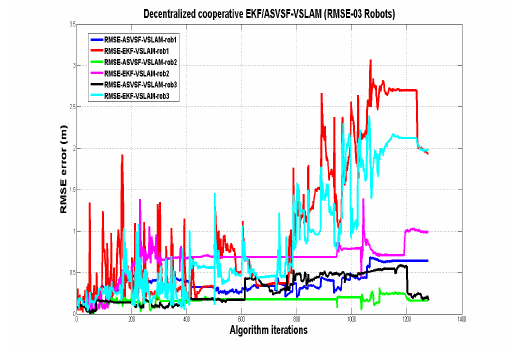
Fig. 11: RMSE Results with non-centered Gaussian